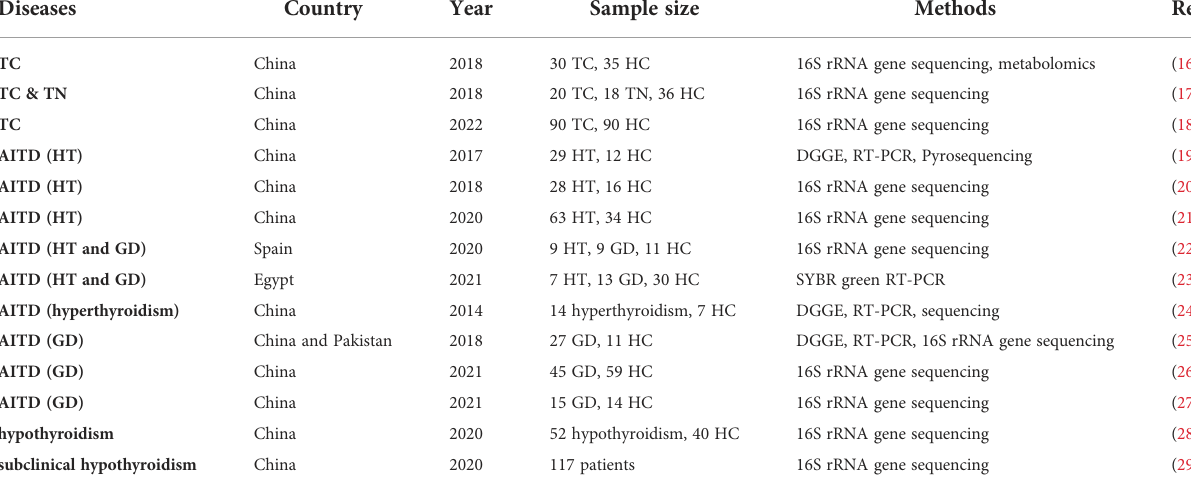
TABLE 1 Overview of research on gut microbiota and thyroid diseases.